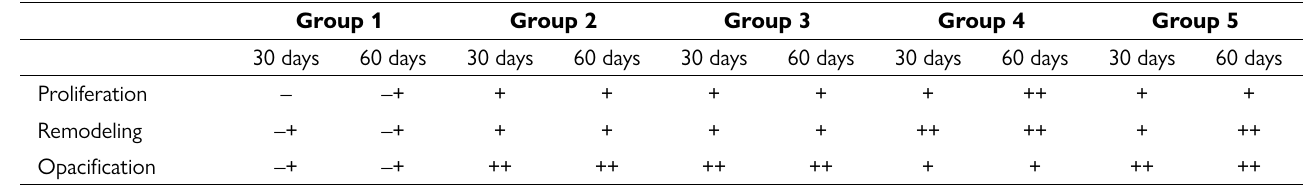
Table 1. Qualitative parameters for bone growth and consolidation by CT